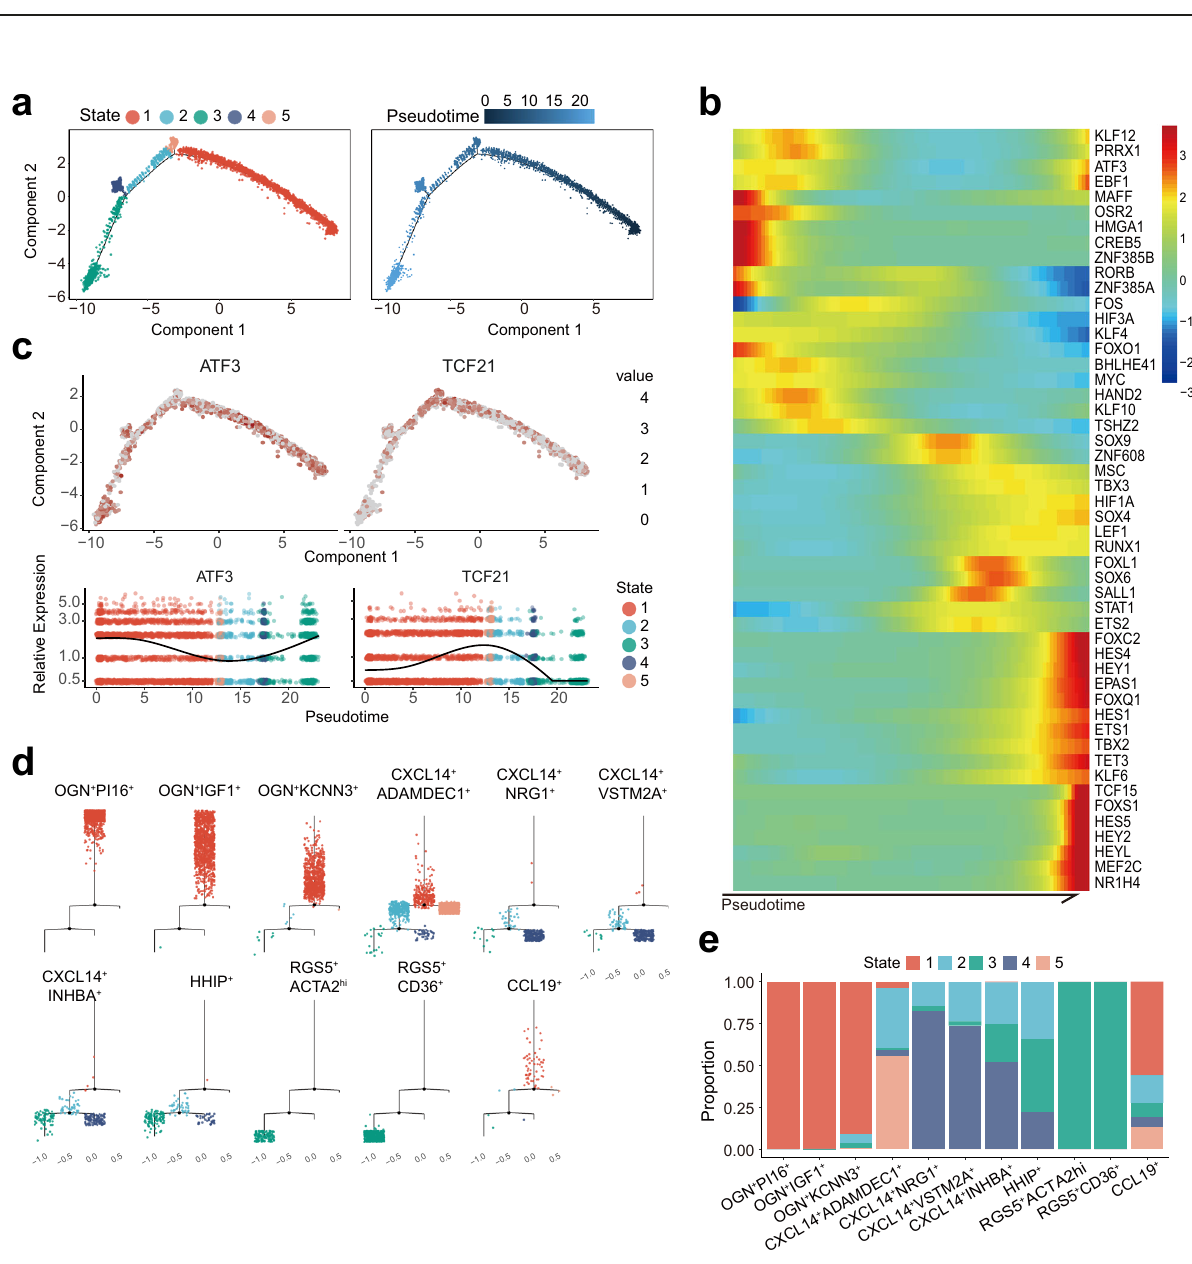
Fig. 2 The patterns of gene expression pro fi les in human colonic mucosa fi broblasts and myo fi broblasts. a – c Dot plot showing the scaled expression of several key biological function-related gene sets of each cluster in mucosa. Gene sets were downloaded from the Molecular Signatures Database (MSigDB). The color gradient represents the average expression of each gene in each cluster scaled across all clusters. The dot size represents the percentage of positive cells in each cluster. The colors representing each cluster in the color band correspond to those in Fig. 1a. a Genes encoding structural components of basement membranes (M5887) and collagen proteins (M3005). b Genes encoding core extracellular matrix components, including ECM glycoproteins, collagens and proteoglycans (M5884), excluding the genes contained in Fig. 4A. c Genes encoding cytokines (GO:0005125) and growth factors (GO:0008083). d Gene Ontology analysis of marker genes for each cluster. e KEGG enrichment analysis of marker genes for each cluster.